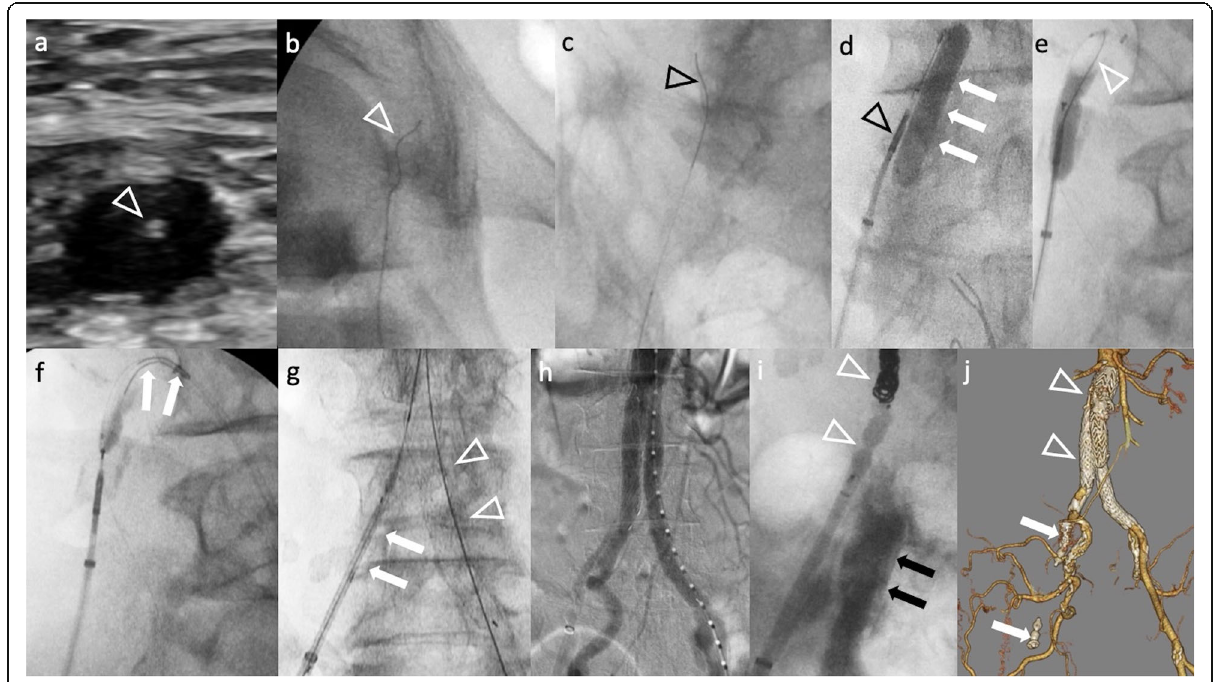
Fig. 2 Procedure detail. a The occluded right CFA was punctured under ultrasound guidance (arrowhead: tip of the needle), b A guidewire (arrow heads) was advanced via the occluded right CFA, c A guidewire was advanced to the subintimal space of the right CIA, d The OUTBACK reentry device in the subintimal space (arrow head) was directed to an angioplasty balloon located at the lumen of the right CIA (arrows), e Insertion of the wire (arrowhead) into the punctured balloon, f Retracting the punctured balloon with the wire established a through and through wire, g Main body graft (arrowheads) which was delivered via left iliac artery was deployed and then the contralateral limb (arrows) was delivered via right iliac artery, h Completion angiogram shows a successful exclusion of the AAA, i Embolization of the tract was performed using coils and a plug (arrowheads) where a 12F sheath was advanced. A leakage of contrast media (arrows) indicates vessel disruption, j Post-operative CT shows implanted endograft (arrowheads), coils and plugs (arrows), and preserved collateral channels. AAA: abdominal aortic aneurysm, CFA: common femoral artery, CIA: